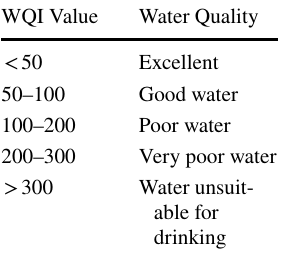
Table 2 Ground water classification based on Water Quality